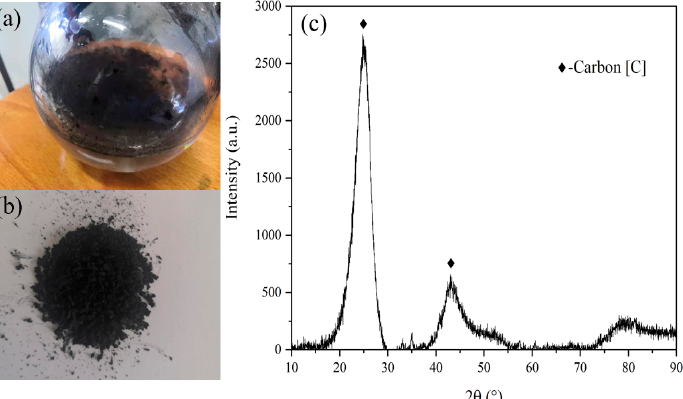
Figure 9. Carbon deposition during cracking process, ( a ) flask for cooling; ( b ) collected carbon from the flask ( a ); ( c ) XRD pattern of generated carbon.